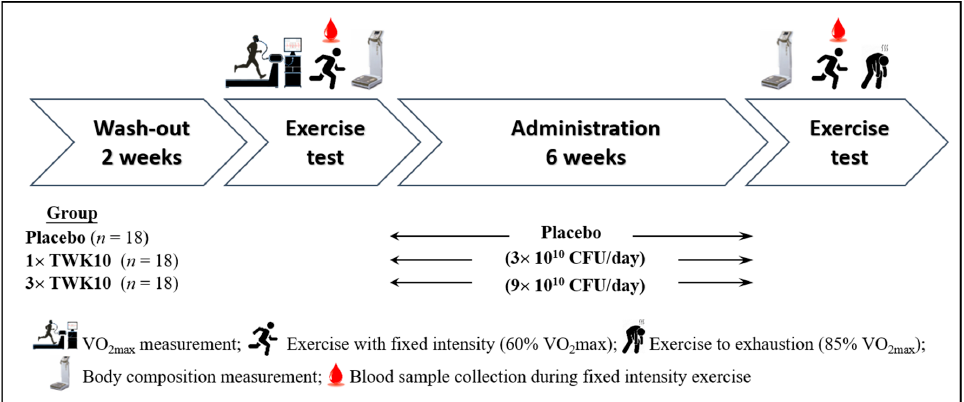
Figure 1. Experimental design. We adopted a double-blind test in which the subjects (18 subjects;